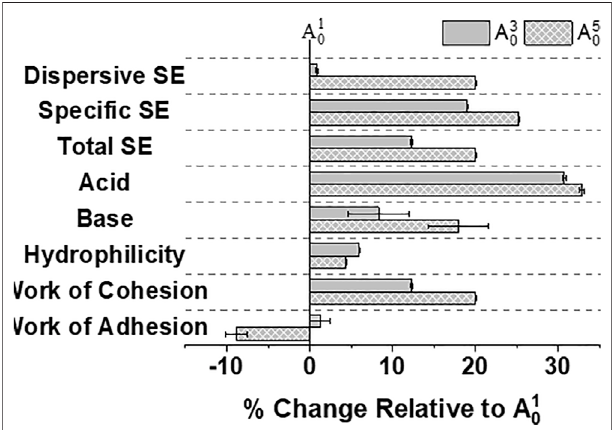
FIGURE 10 | Percentage changes in surface energy as a function of wetting and drying cycles for Sample A . Note: all quanti fi ed changes are relative to the initial corn stover